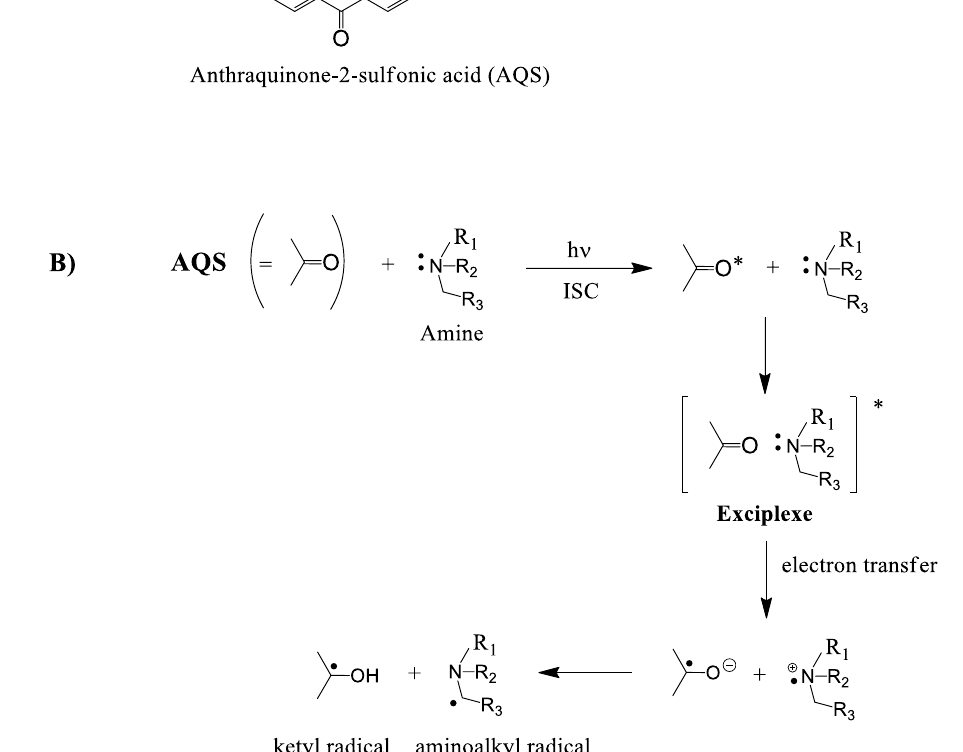
Figure 2. ( A ) Example of a type II photoinitiator and ( B ) mechanistic approach with anthraquinone-2-sulfonic acid (AQS) under light irraditation.